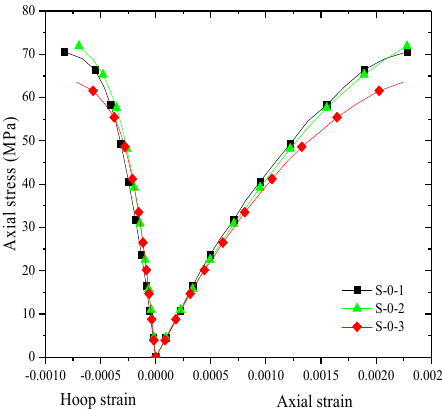
Figure 4. Stress–strain curves of the unconfined high-strength concrete specimens under quasi-static compression.